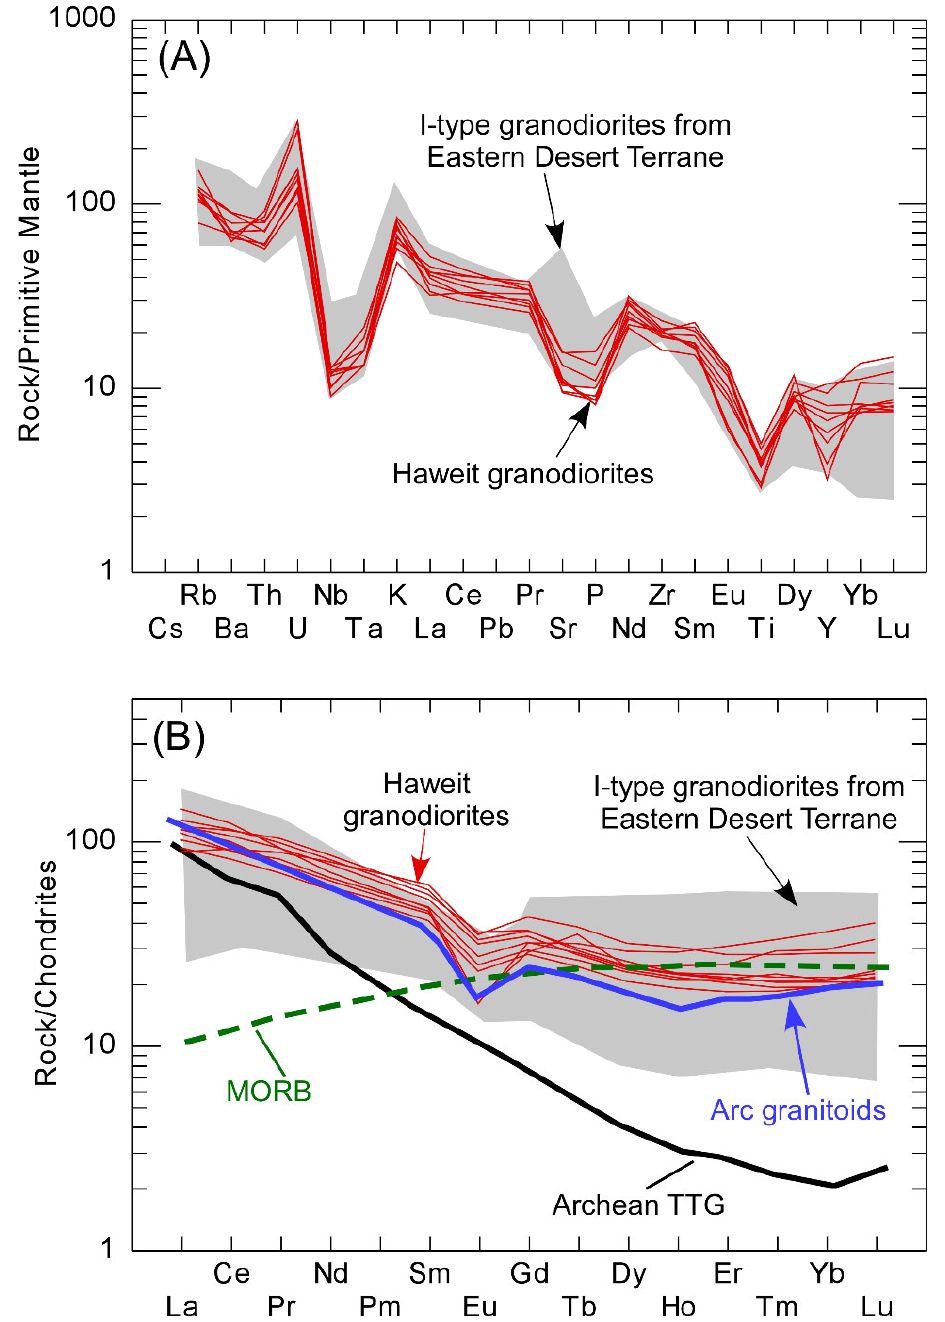
Figure 6. ( A ) Multi-elements spider diagrams normalized to the primitive mantle; ( B ) REEs patterns normalized to chondrite for the Haweit granodiorite. The normalization values of both primitive mantle and chondrite are from Sun and McDonough [44]. The data of mid-oceanic ridge basalt (MORB; [44]), arc granitoids [3], and Archaen tonalite–trondhjemite–granodiorite (TTG; [45]) are presented. The field of I-type granodiorites from the Eastern Desert is adopted from El-Bialy and Omar [41] and Abdel-Rahman